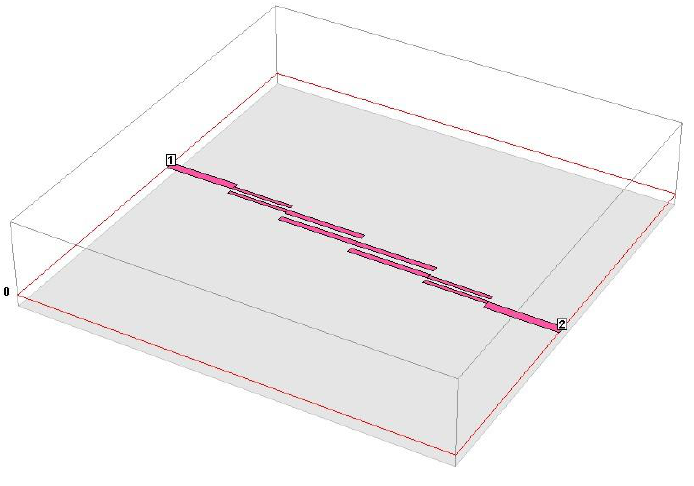
Figure 2. 3D view of the filter Table 1. Microstrip filter